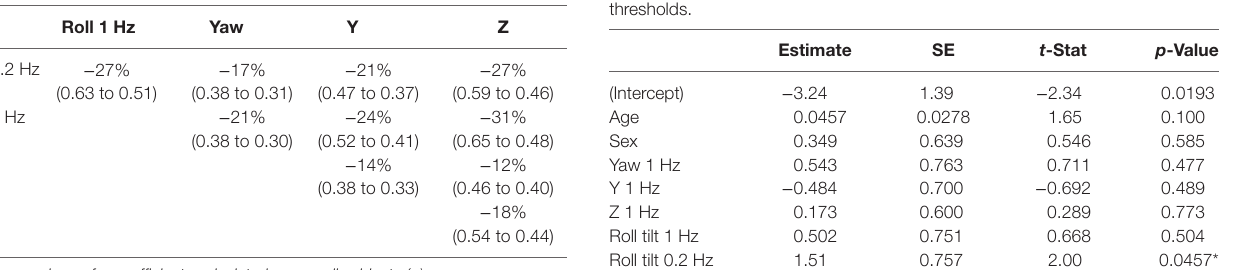
TaBle 6 | Results of a multiple logistic regression to predict the chance of failing condition 4 of the balance test based on age and log-transformed vestibular